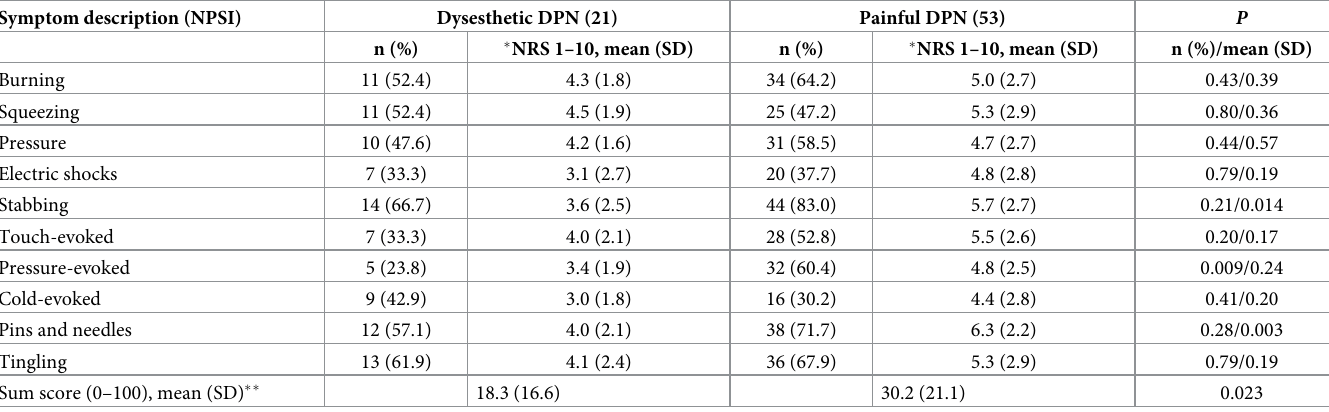
Table 3. Distribution of symptoms using the Neuropathic Pain Symptom Inventory (NPSI).